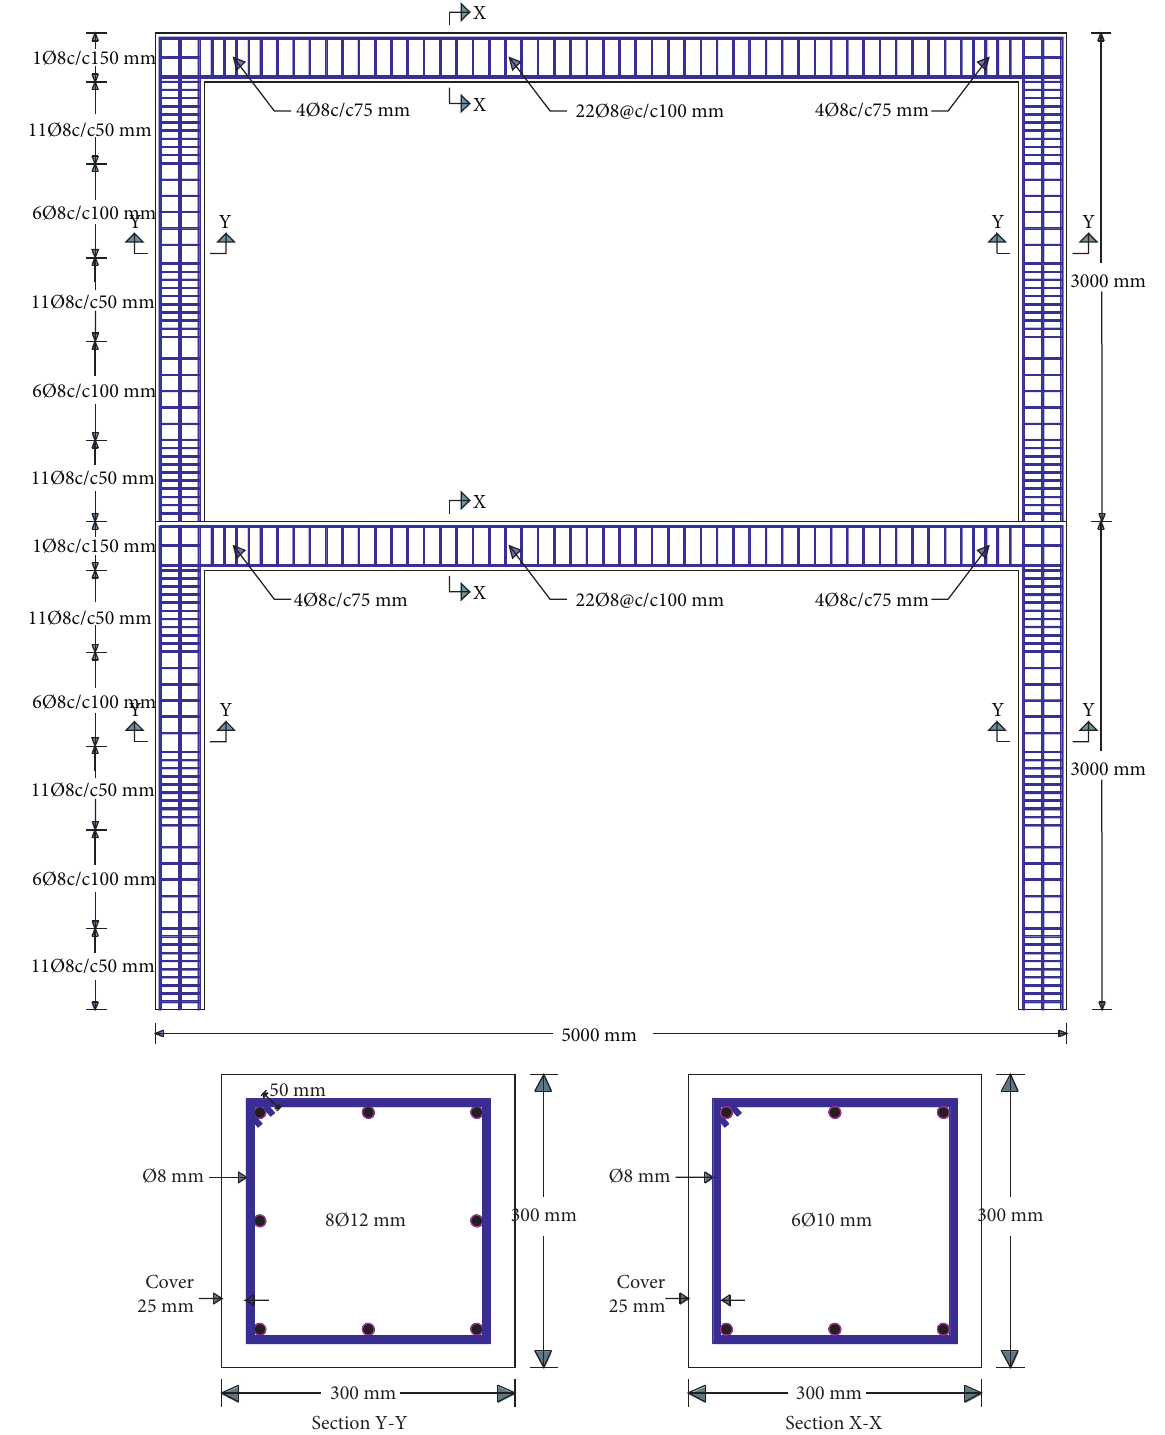
Figure 11: Reinforcement detailing for